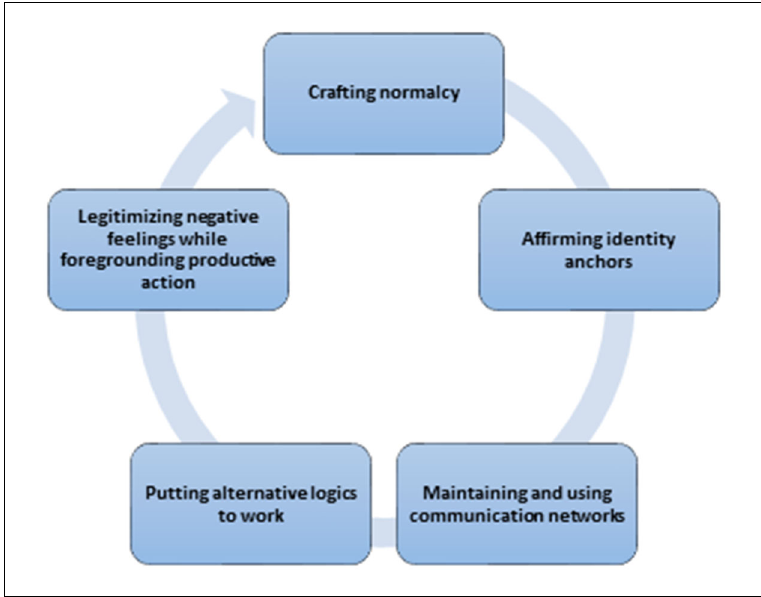
Source: Original figure based on information from Buzzanell,